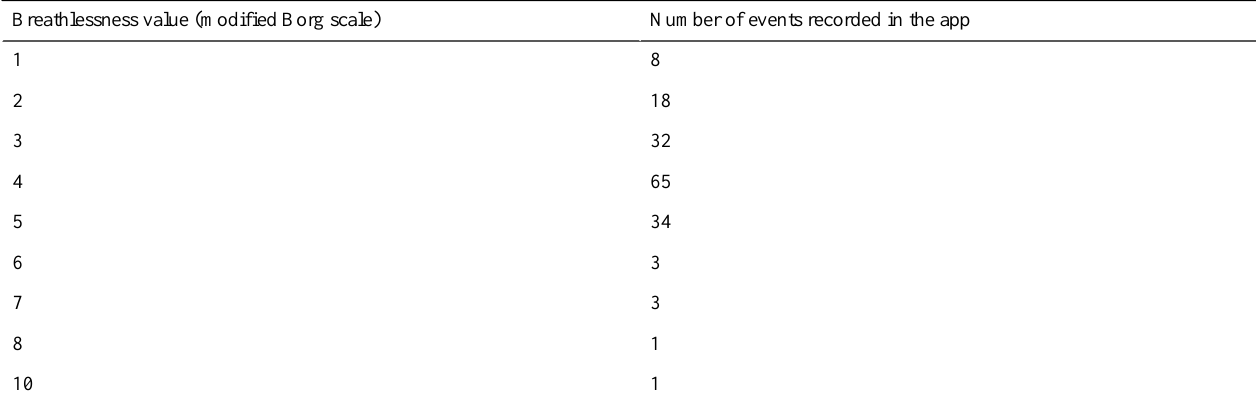
Table 2. Frequency for Borg breathlessness values recorded by the experiment